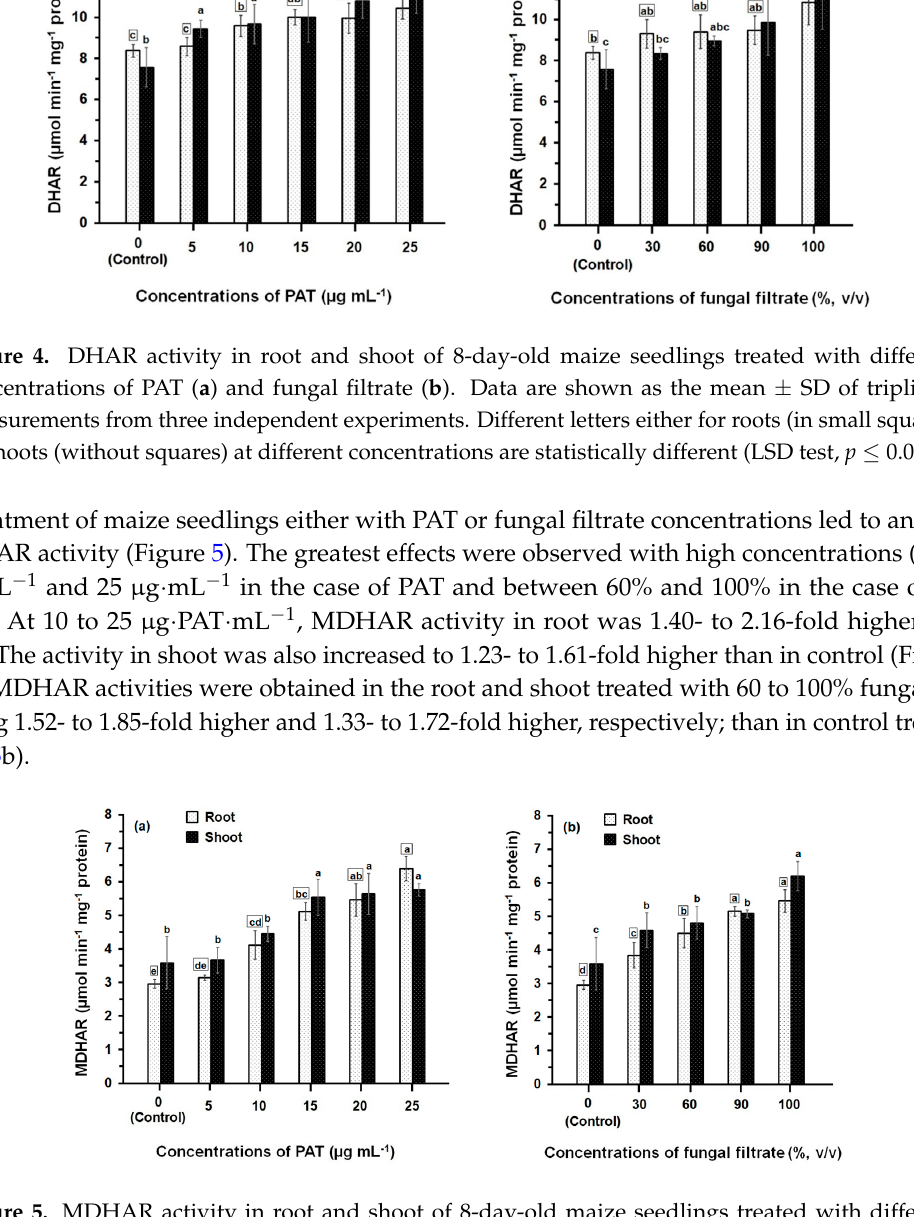
Figure 5. MDHAR activity in root and shoot of 8-day-old maize seedlings treated with different concentrations of PAT ( a ) and fungal filtrate ( b ). In this figure, data are shown as the mean ± SD of triplicate measurements from three independent experiments. Different letters either for roots (in small squares) or shoots (without squares) at different concentrations are statistically different (LSD test, p ≤ 0.05).